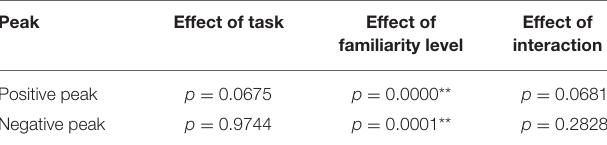
TABLE 5 | Summary of the ANOVA